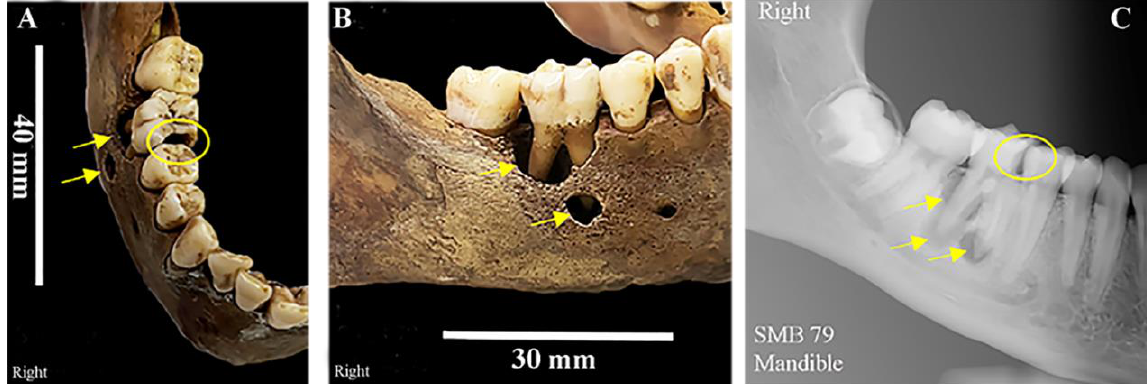
Figure 3. SMB 79, subadult (dental age range 15.5 – 16.5 years (±1 year) — skeletal assessment age range 16 – 18 yrs.). ( A , B ): Yellow circle shows caries in the mesial occlusal surface of the lower right permanent first molar (M1 — FDI number 46). Yellow arrows indicate the periapical cavity and opening in the buccal surface of the alveolar bone. ( C ): Periapical dental radiograph of the mandible — yellow arrows show the extent of the cavity surrounding the roots of the M1 molar, and the ‘opening’ in the alveolar bone adjacent to the apex of the mesial root. The yellow circle highlights caries that extended to involve the pulp. © Angela Gurr.